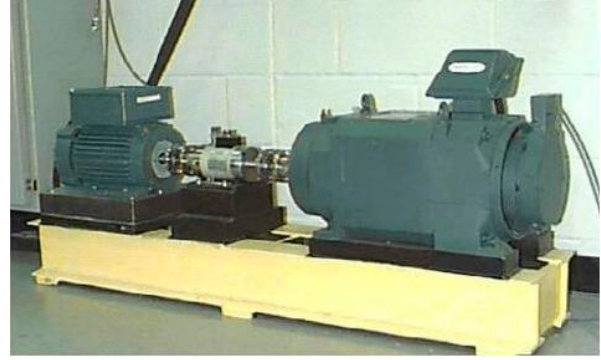
Figure 6. Bearing simulation failure test bench of Western Reserve University.